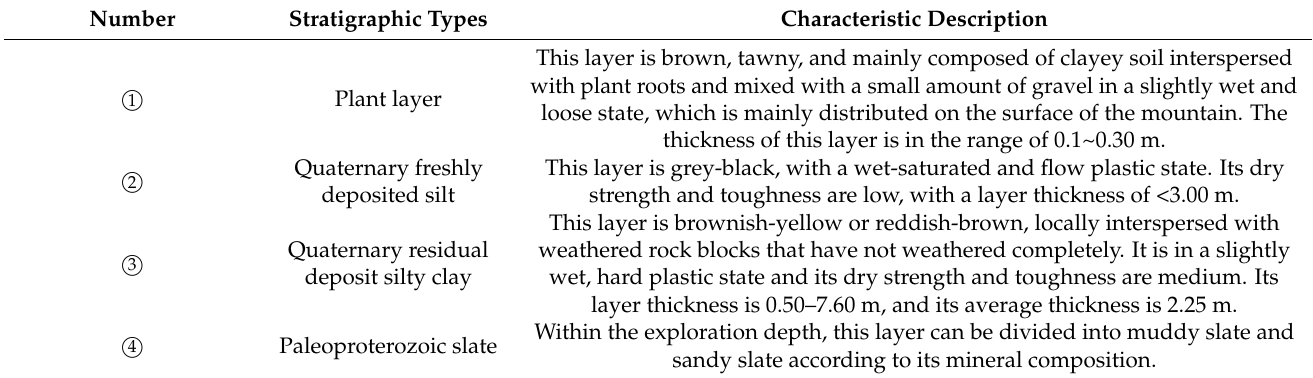
Table 1. Summary of stratigraphic lithology characteristics.